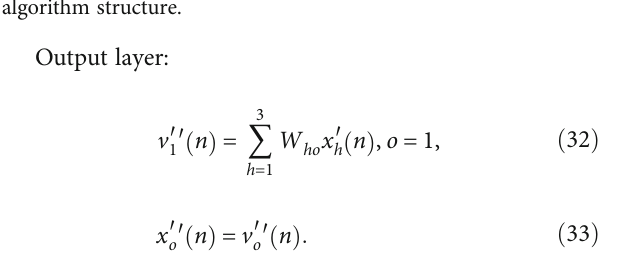
Figure 4: PIDnn control algorithm